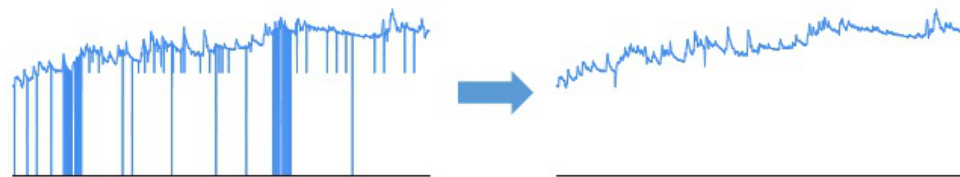
Figure 5. Illustration of forward interpolation applied to data provided by an electrodermal activity (EDA) sensor.